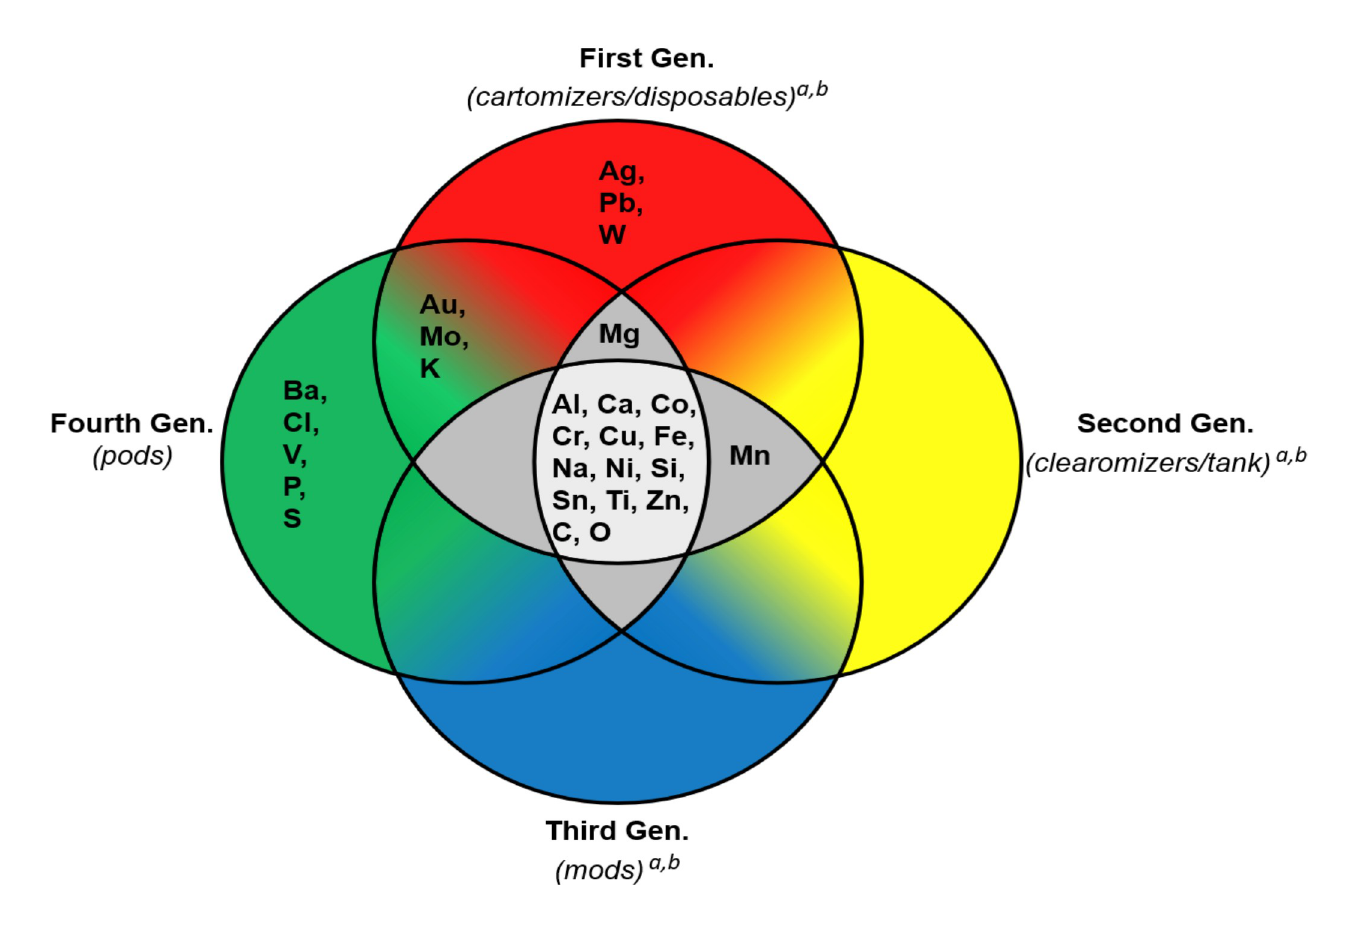
Fig 9. Venn diagram showing elements identified in atomizer components of four EC generations. Al = aluminum, Co = cobalt, Cr = chromium, Cu = copper, Fe = iron, Ni = nickel, Sn = tin, Ti = titanium, Zn = zinc, Ag = silver, Pb = lead, W = tungsten, V = vanadium, Au = gold, Mo = molybdenum, Mn = manganese, Mg = magnesium, C = carbon, Ca = calcium, Na = sodium, O = oxygen, Si = silicon, Ba = barium, Cl = chlorine, P = phosphorus, S = sulfur, K = potassium. a = Williams et al. 2019a; b = Williams et al. 2019b.